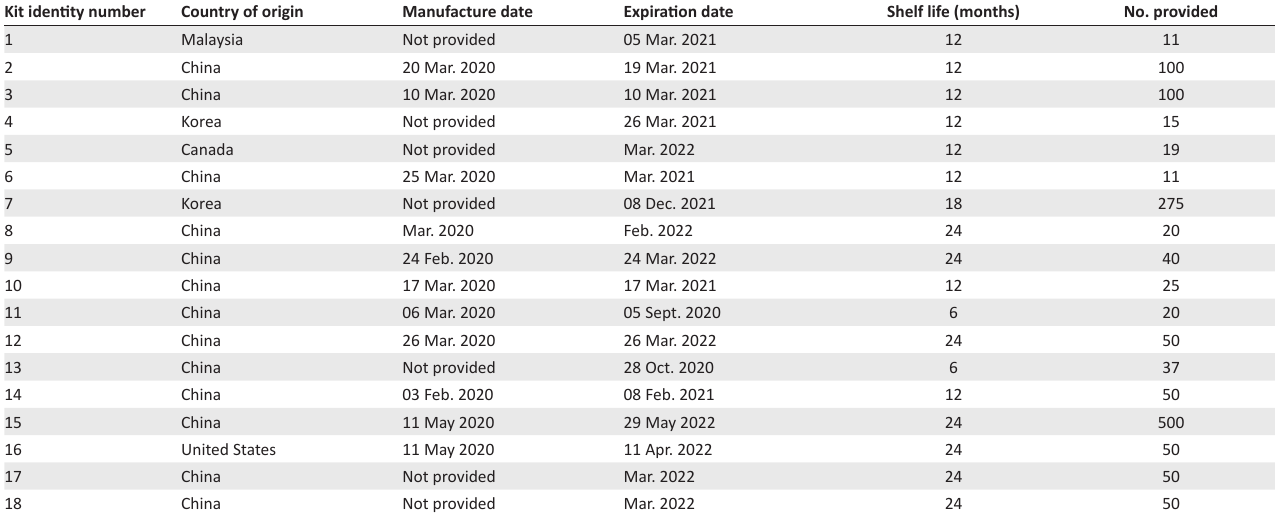
TABLE 1: Characteristics of COVID-19 point-of-care test kits submitted to the Kenya Medical Research Institute by the Pharmacy and Poisons Board, Nairobi, Kenya, for pre-evaluation assessment, March–May